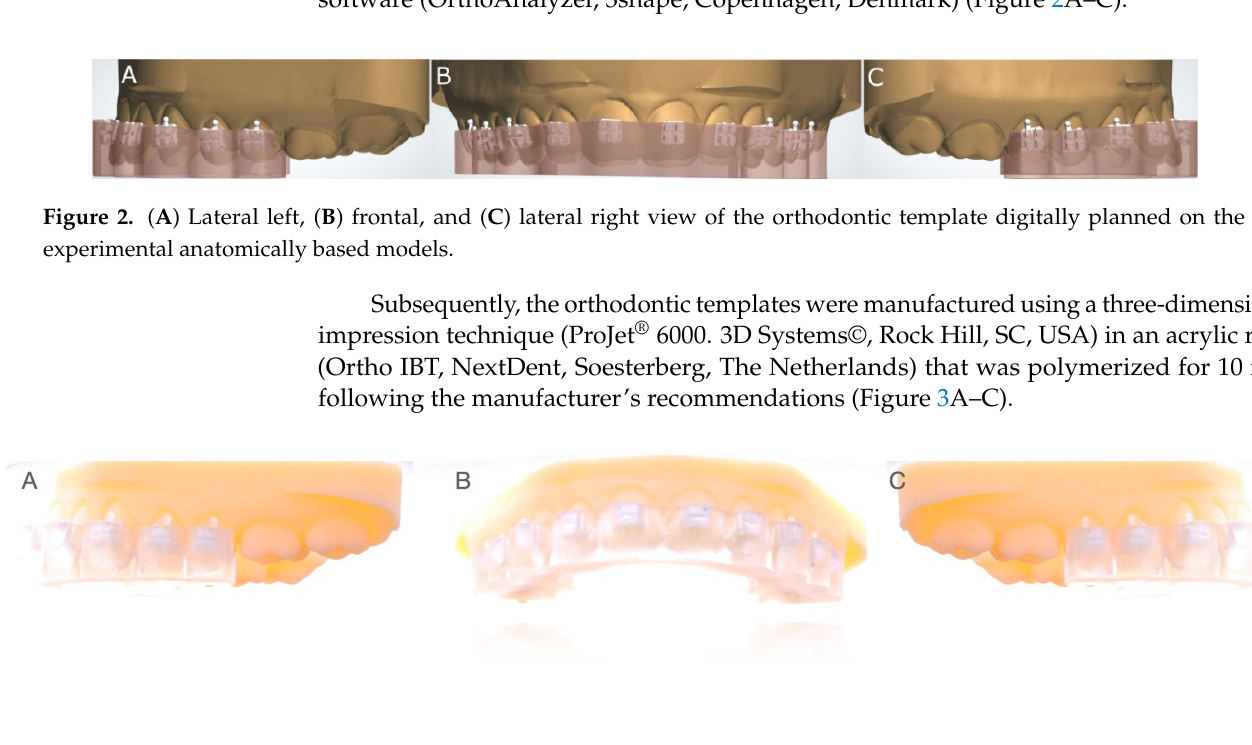
Figure 1. ( A ) Lateral left, ( B ) frontal, and ( C ) lateral right view of the fixed buccal multibracket appliances digitally planned on the experimental anatomically based models.